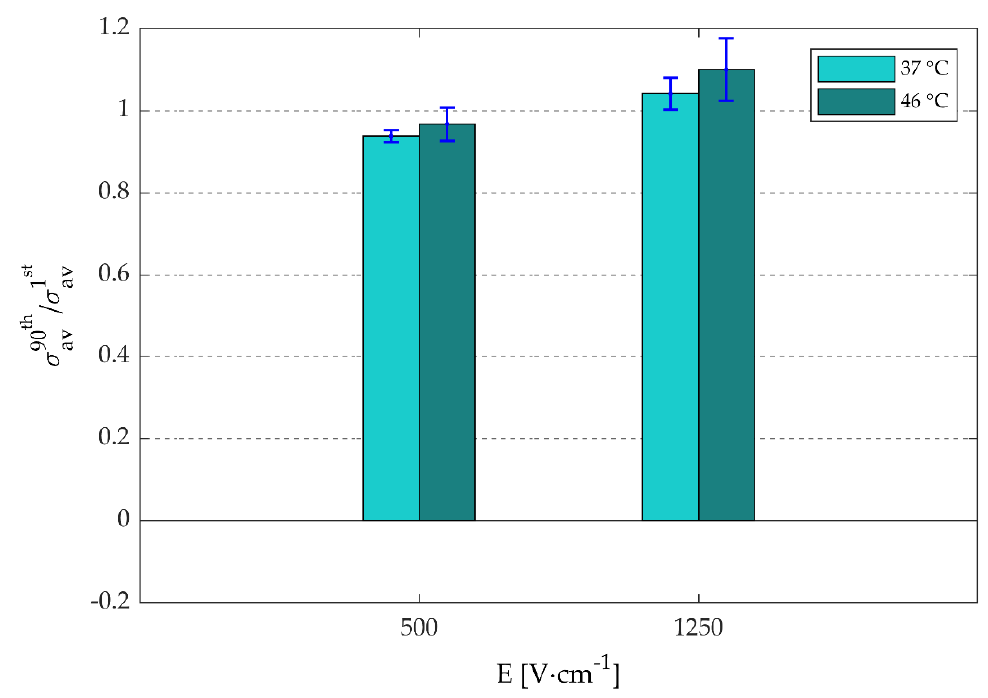
Figure 8. The average ratio (n = 3; including ±SD) between the average electric conductivities (σ av [S ⋅ m −1 ]) of the 90th and the first pulse are shown as a function the electric-field strength (E [V ⋅ cm −1 ]) and target temperatures. The data are provided in Supplementary Materials Table S2.